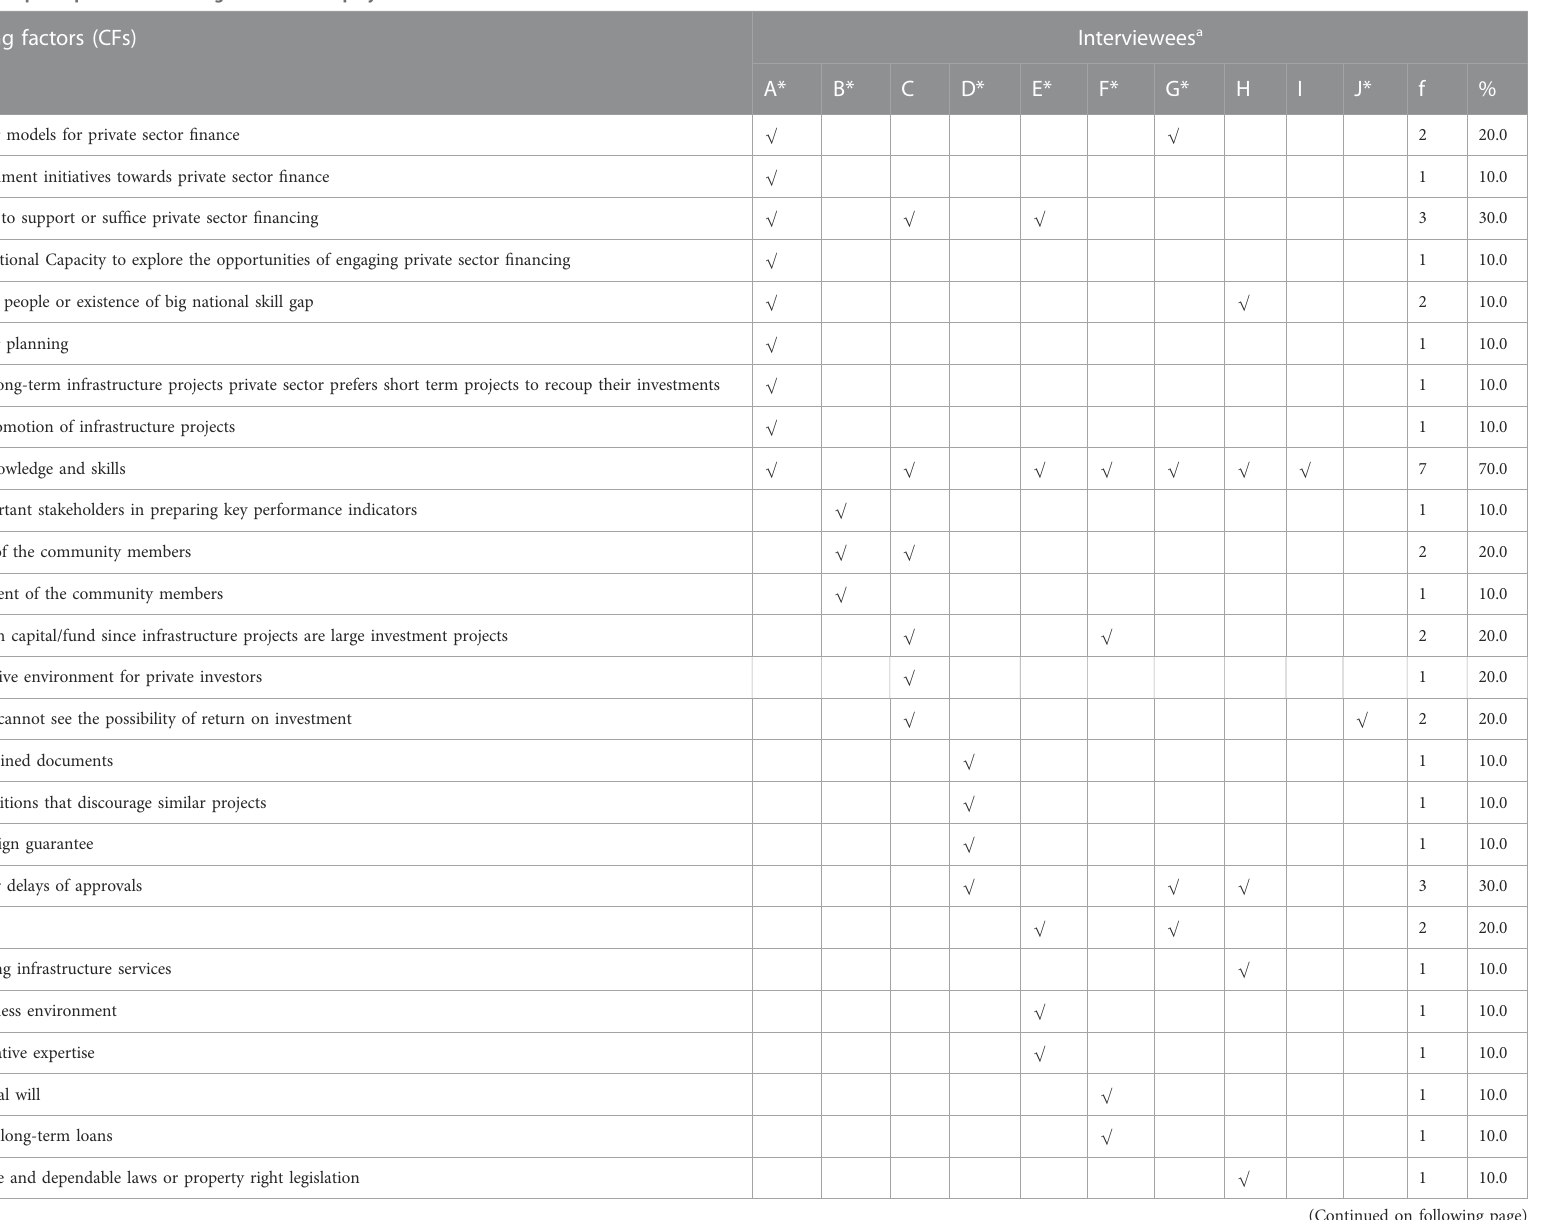
TABLE 3 CFs for private sector participation in fi nancing infrastructure